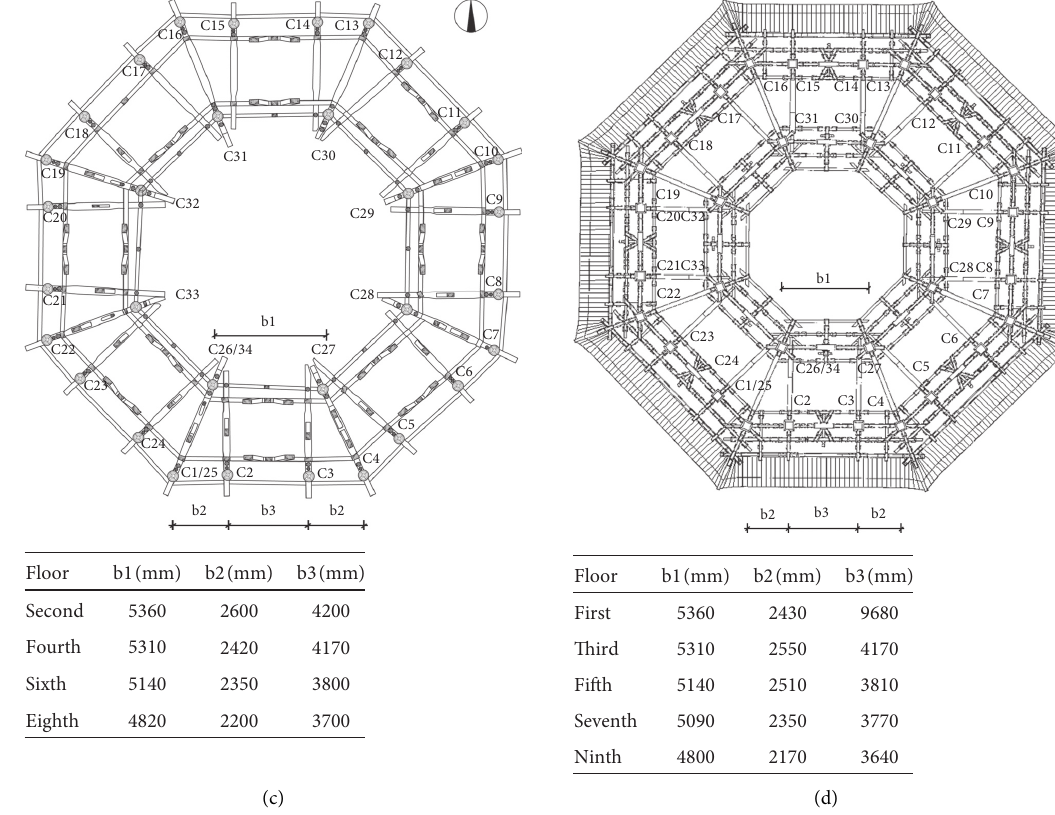
Figure 2: Column layout (a) on the first floor, (b) on the third, fifth, seventh, and ninth floors, and (c) on the second, fourth, sixth, and eighth floors. (d) Layout of the column heads and eaves on the first, third, fifth, seventh, and ninth